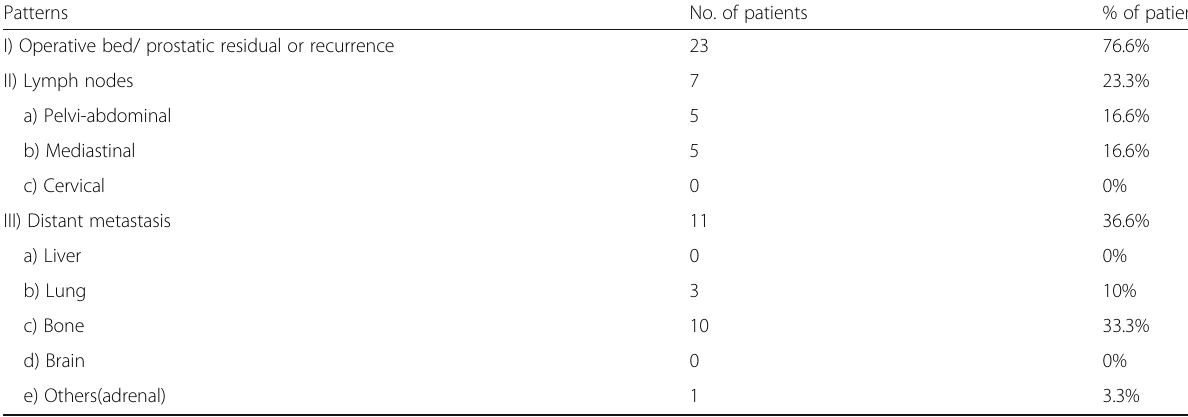
Table 3 Patterns of tumor recurrence/residual including lymph nodes and distant metastases by 68Ga-labelled PSMA-ligand PET/CT study with their number (No.) and percent (%)